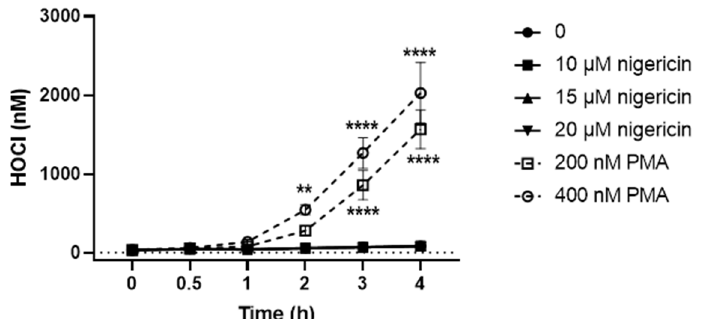
Figure 3. Differentiated PLB-985 cells produce HOCl when stimulated with PMA, but not with nigericin. Differentiated PLB-985 cells (2 × 10 6 cells/mL) were stimulated with PMA (200 or 400 nM) or nigericin (10, 15 or 20 µ M) in the presence of R19-S (10 µ M), with changes in fluorescence recorded at λ EX 515 nm and λ EM 550 nm over 4 h. Symbols • , (cid:4) , (cid:78) and (cid:72) are overlaid, as no HOCl was detectable on stimulation with nigericin. Data represent the mean ± S.E.M. of 3 experiments. **, and **** indicate a significant ( p < 0.01, 0.0001) change on comparing each concentration of PMA to the non-treated control by a two-way ANOVA with Dunnett’s multiple comparisons test.